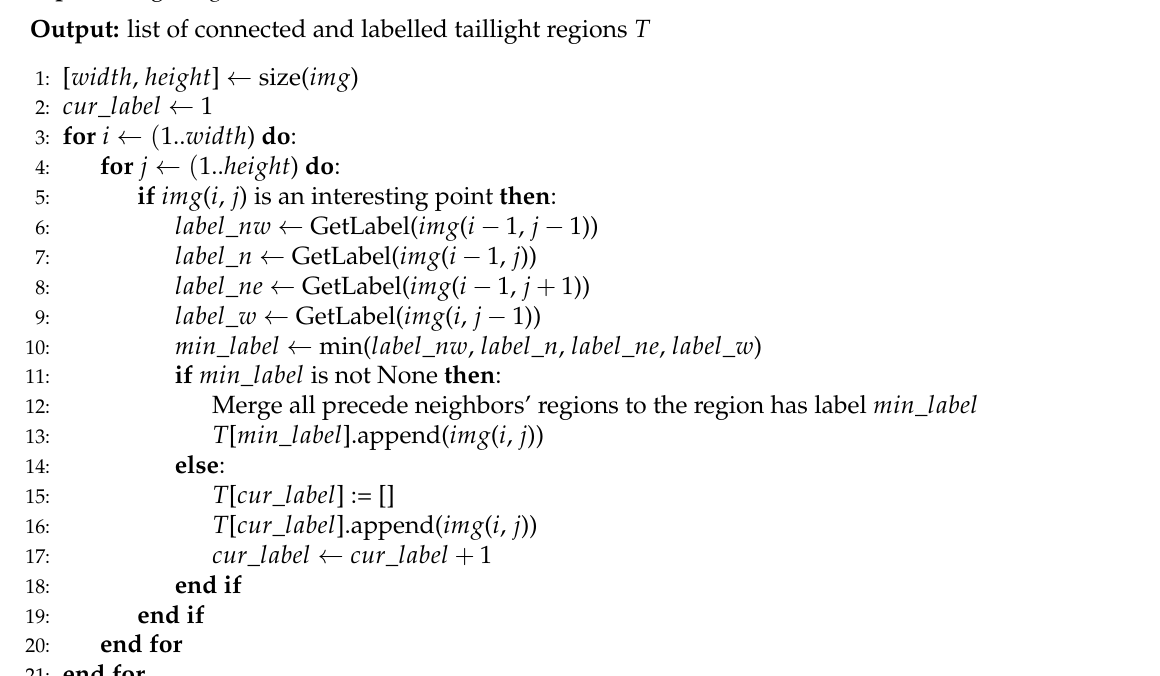
Algorithm 1 Procedure